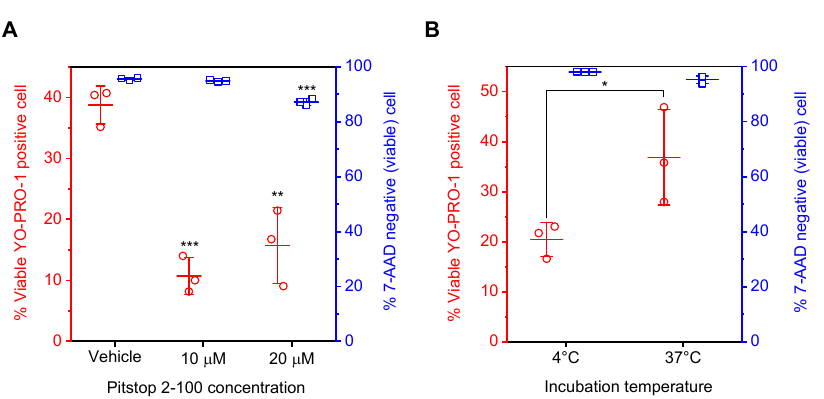
Figure 5. The effect of endocytosis inhibition on YO-PRO-1 uptake. ( A ) The effect of pretreatment of cells with an endocytosis inhibitor on YO-PRO-1 uptake. The population of YO-PRO-1-positive viable cells and cell viability after short-circuiting is shown. Data are expressed as the mean ± SD of triplicate measurements. Statistical significance was determined using one-way ANOVA followed by Tukey’s multiple comparison tests, ∗∗ p < 0.01 and ∗∗∗ p < 0.001 vs. vehicle. ( B ) The effect of incubation temperature after short-circuiting on YO-PRO-1 uptake. Data are expressed as the mean ± SD of triplicate measurements. Statistical significance was determined using Student’s t -tests, ∗ p <